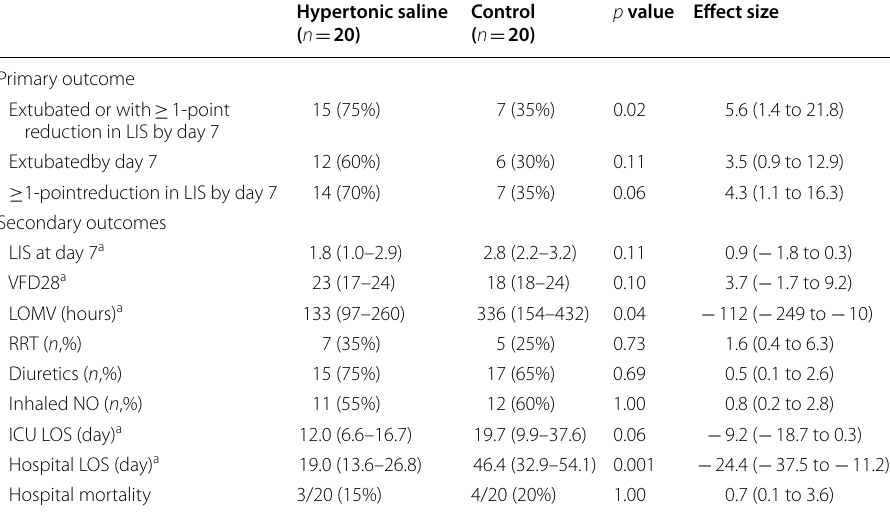
Table 2 Primary and secondary outcomes in the